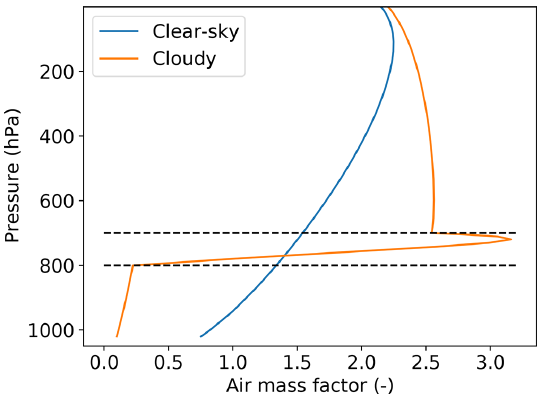
Figure 9. Altitude-resolved air mass factor of NO 2 at 440nm for a cloudy scene and a clear-sky scene. The scattering cloud layer is located between 700 and 800hPa with a cloud optical thickness of 10. The dashed lines indicate the cloud top and base pressure. The surface albedo is 0.05. The geometry is as follows: nadir view with a solar zenith angle of 30 ◦